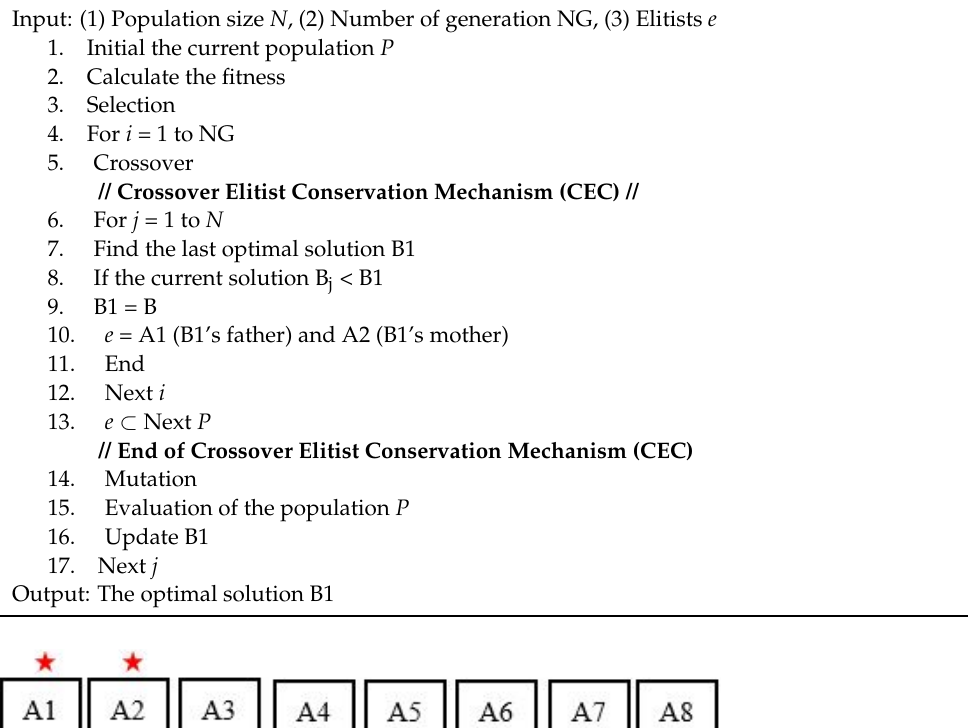
Algorithm 1 Crossover Elitist Conservation Genetic Algorithm